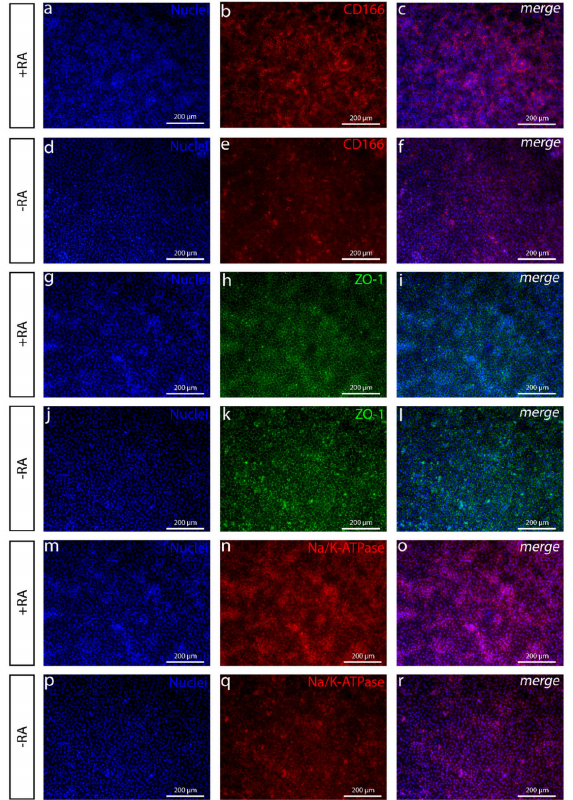
Figure 4. Immunofluorescence images of common CEnC markers with or without RA shown for the Regea08/017 hESC line. After day 11 of differentiation, ( a – f ) CD166 is substantially stronger when ( a – c ) RA is used (+RA) in the induction compared to when ( d – f ) RA is absent ( − RA). ( g – l ) Tight junction marker ZO-1 shows more polygonal and tightly packed cells ( g – i ) with +RA compared to the cell culture ( j – l ) without − RA. ( m – r ) Na + /K + -ATPase is important for the pump activity, and the expression was higher in ( m – o ) the cell culture with RA compared to ( p – r ) the cell culture without RA. Scale bar ( a – r ) 200 µ m. Corresponding human induced pluripotent stem cell (hiPSC) data is shown in Figure